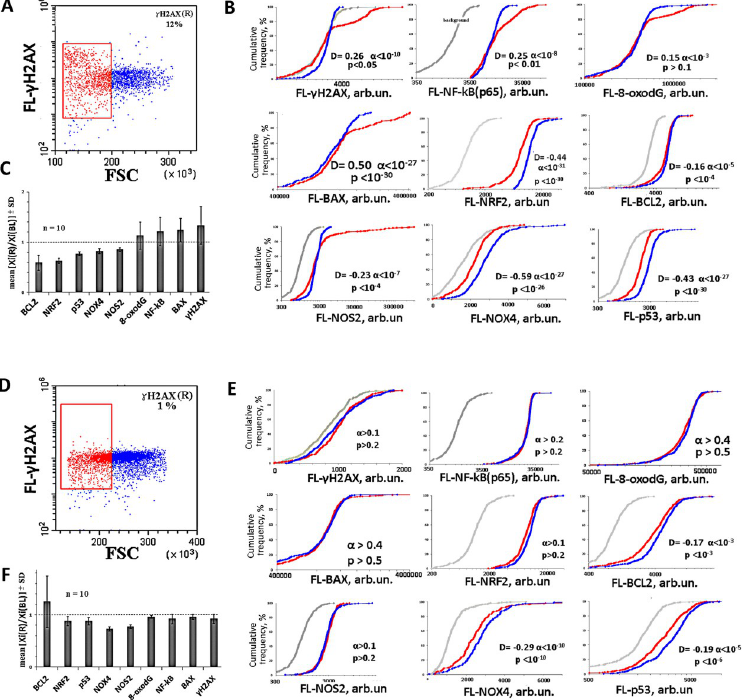
Fig 7. Analysis of the subpopulations of the HC lymphocytes with a high and low γ H2AX(R) index value. ( A and D ) An example of the analysis of the population of lymphocytes. We divided the population into two subpopulations— the cells with relatively small FSC parameter values (red-fraction) and the rest (blue-fraction); ( B and E ) for each fraction, the cumulative distribution of several markers were determined separately. The analyzed marker is indicated along the X-axis. The significance of the observed differences was analyzed using the non-parametric Mann–Whitney test (p) and Kolmogorov–Smirnov test (D and α ). ( C and F ) the ratio of the analyzed indices for red- and blue- subpopulations (mean ± SD for 10 lymphocyte